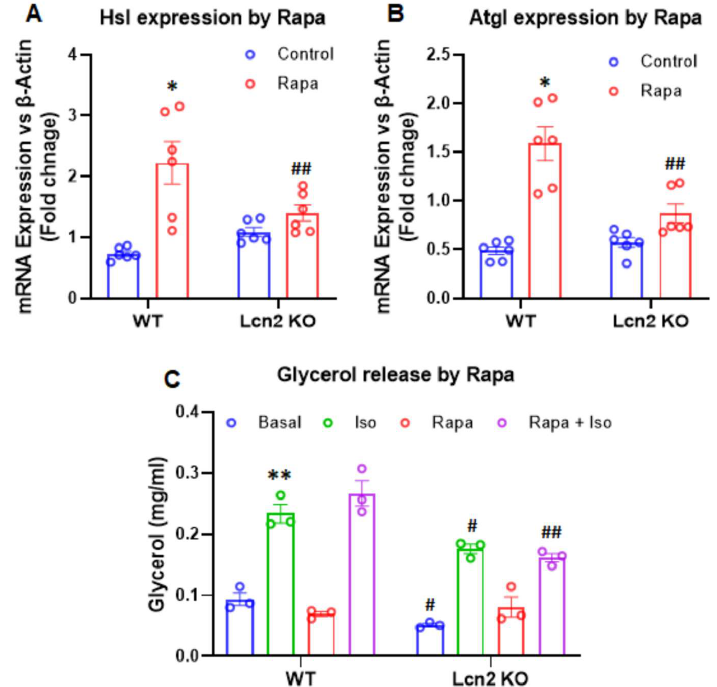
Figure 7. Effect of mTORC1 inhibition by rapamycin on lipolysis in inguinal adipocytes. ( A , B ) The mRNA expression of Hsl and Atgl genes by rapamycin in Lcn2 KO adipocytes. ( C ) Glycerol release in response to the stimulation of isopropanol (Iso), as well as the combination of Iso and rapamycin. Results are presented as mean ± SEM ( n = 6 for ( A , B ); n = 3 for ( C )). * p < 0.05, ** p < 0.01 versus controls. # p < 0.05, ## p < 0.01 versus WT adipocytes. Panel C represents the results from one of two